Question: Summarize what this figure shows in one sentence.
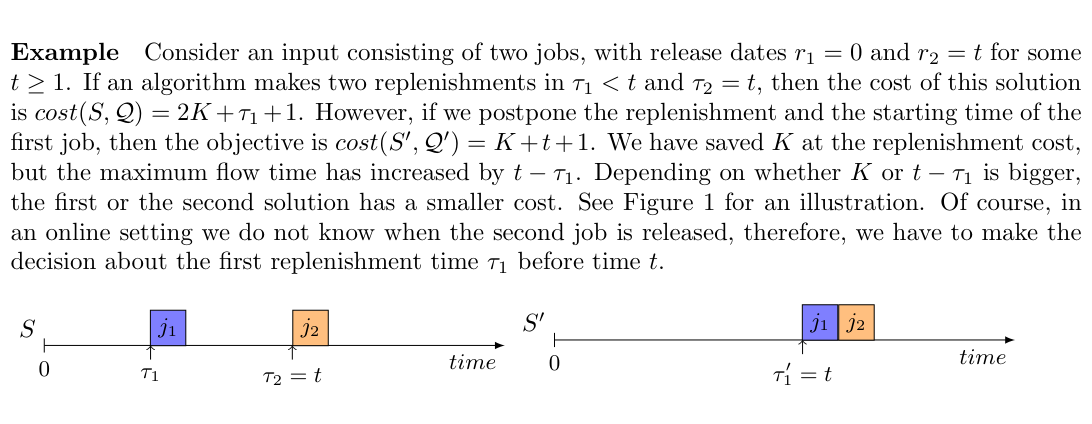
Answer: Two feasible solutions. The arrows below the axis denote the replenishments.